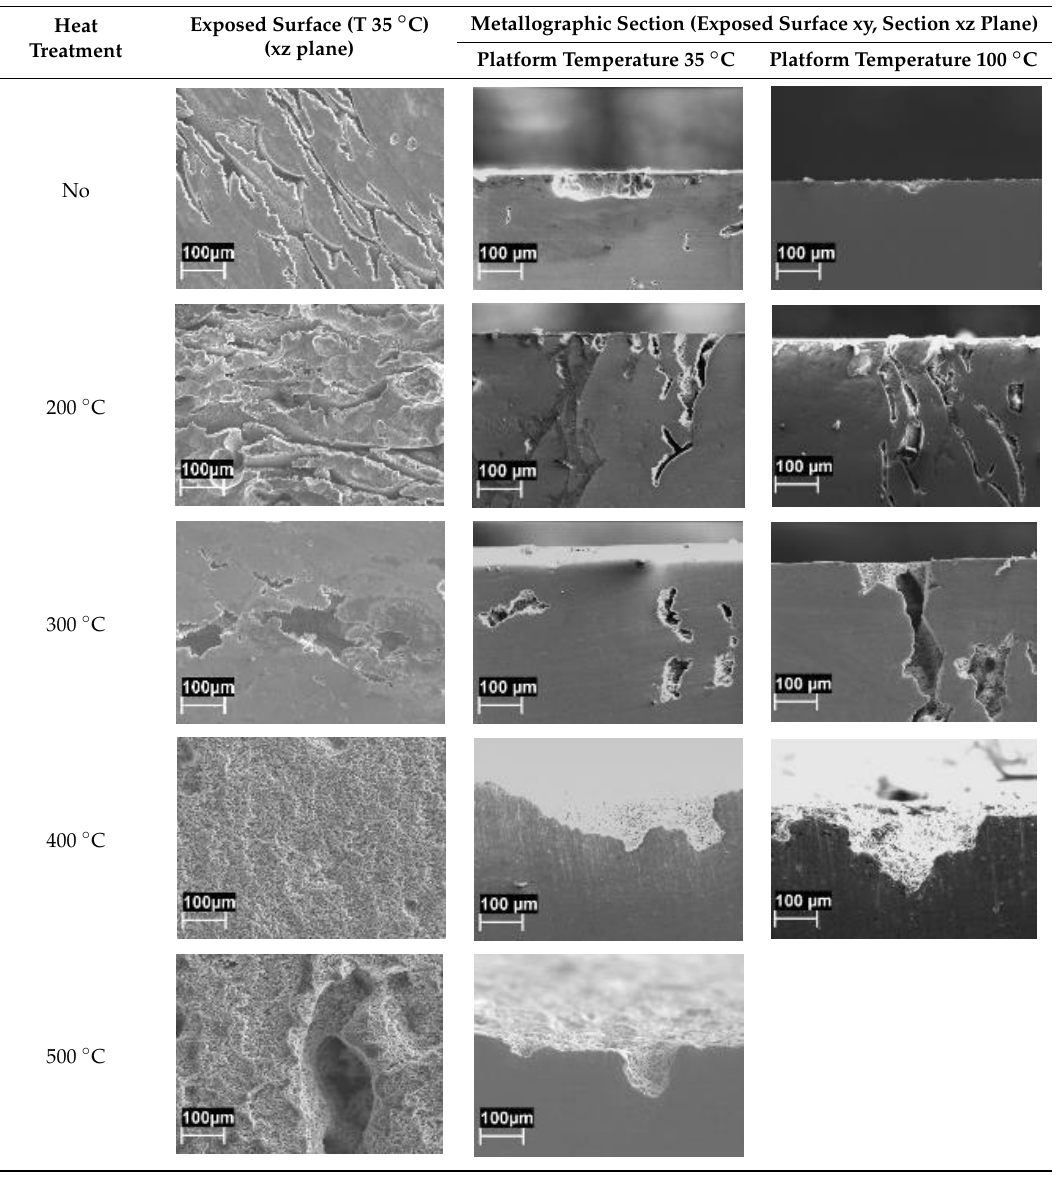
Table 2. Morphology of corrosion after ISO 11846 test.